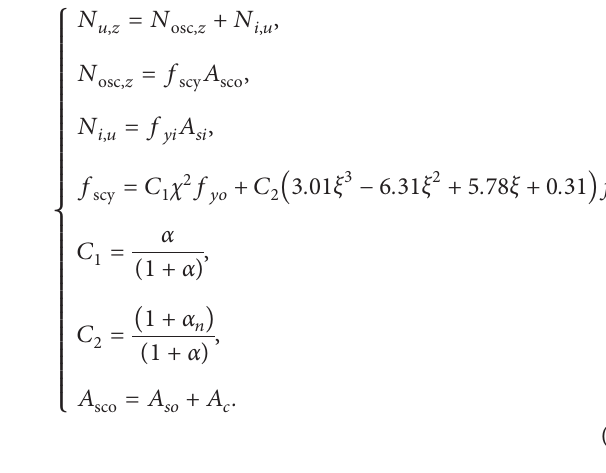
− F j, norm j curves of different yield strength of stainless